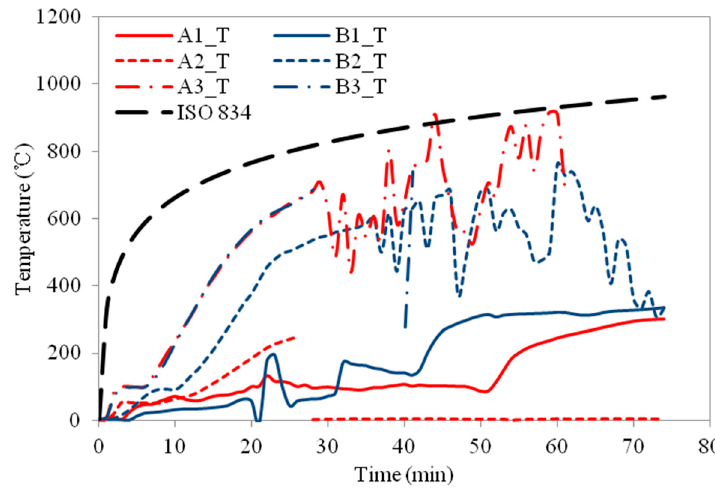
Figure 10. Temperature profiles at the top section for HSS-C1.